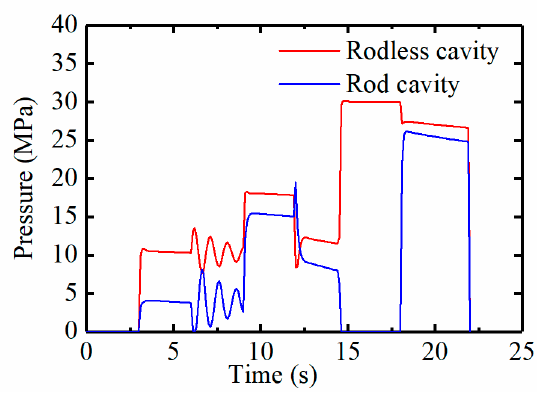
Figure 6. Pressure of the cylinder for the EHDR-EEB.